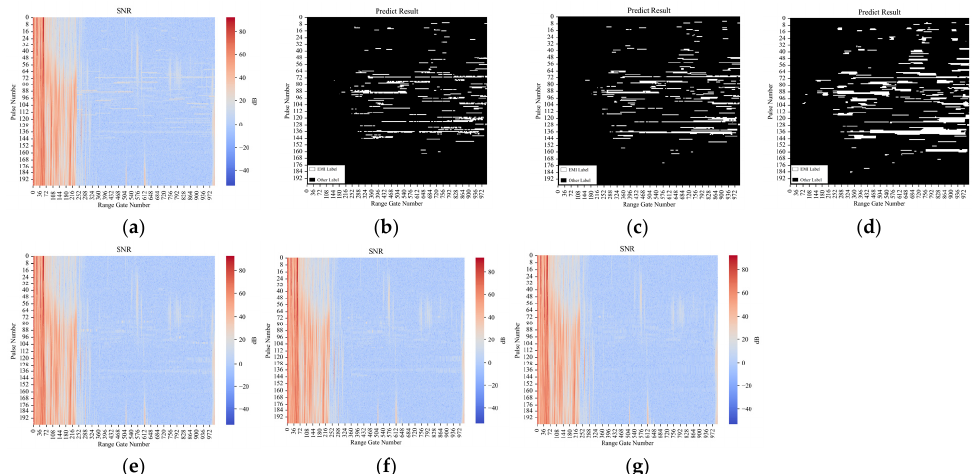
Figure 5. Identification and suppression results of three models for electromagnetic interference. ( a ) Raw data; ( b ) semantic segmentation results of UNet; ( c ) semantic segmentation results of ResNet with UNet structure; ( d ) semantic segmentation results of DeepLab V3+; ( e ) EMI suppression results after UNet semantic segmentation; ( f ) EMI suppression results after ResNet semantic segmentation; ( g ) EMI suppression results after DeepLab V3+semantic segmentation.